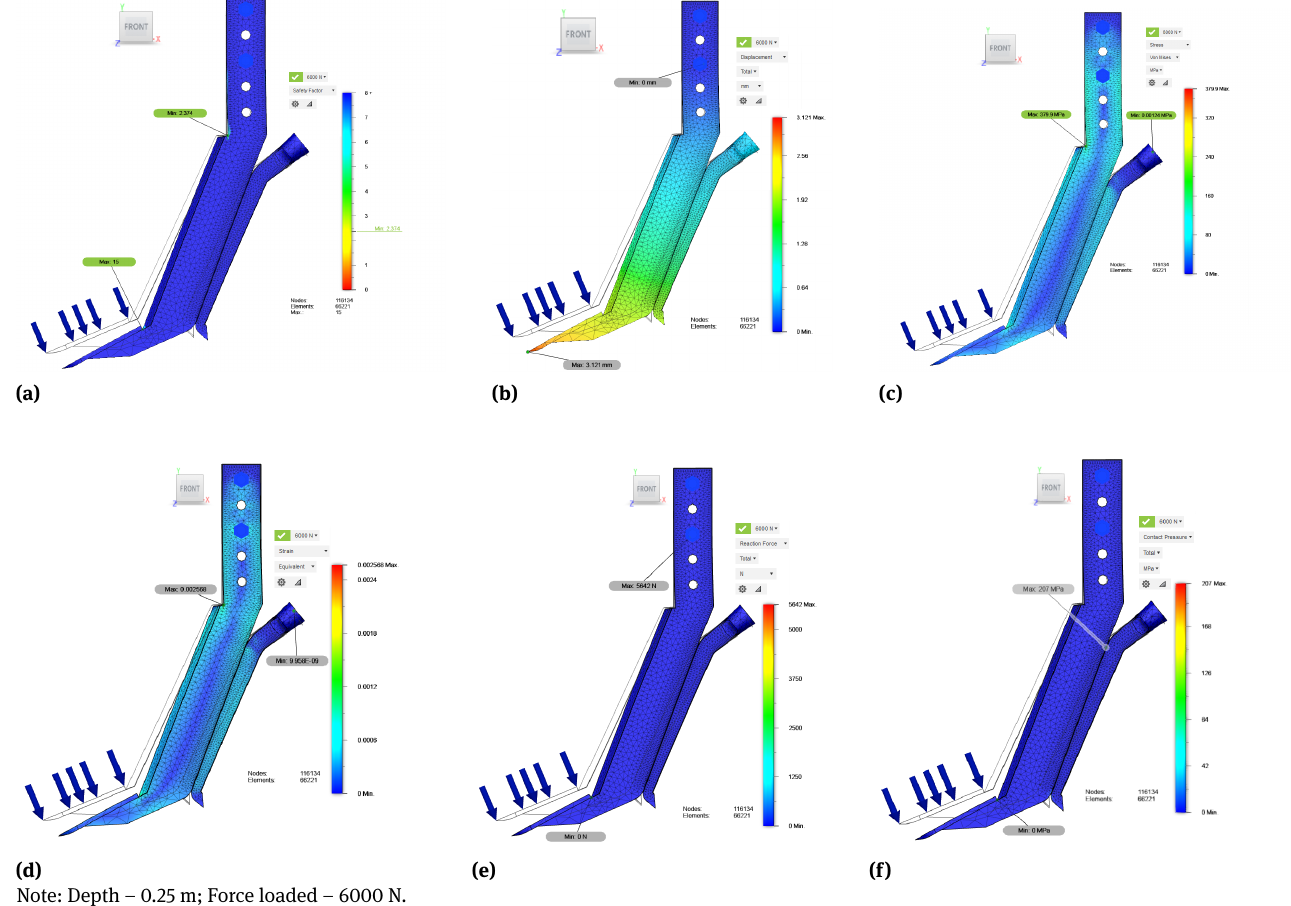
Figure 10: Results of the static analysis of the DPFA a) – Safety factor; b) – Displacement; c) – Stress; d) – Strain Equivalent; e) – Reaction Force; f) – Contact